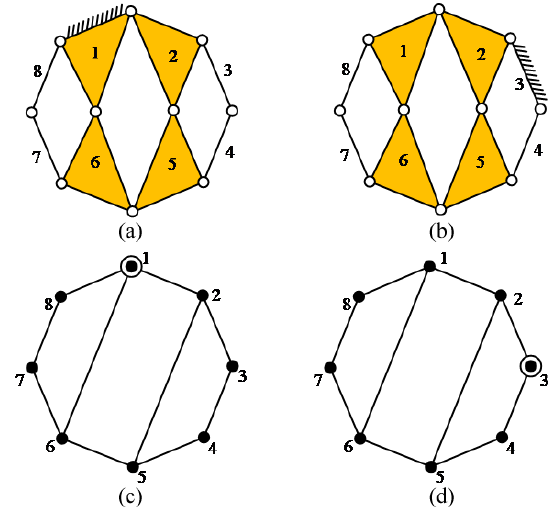
Figure 2. Inversions derived from Fig. 1a and their graphic repre-